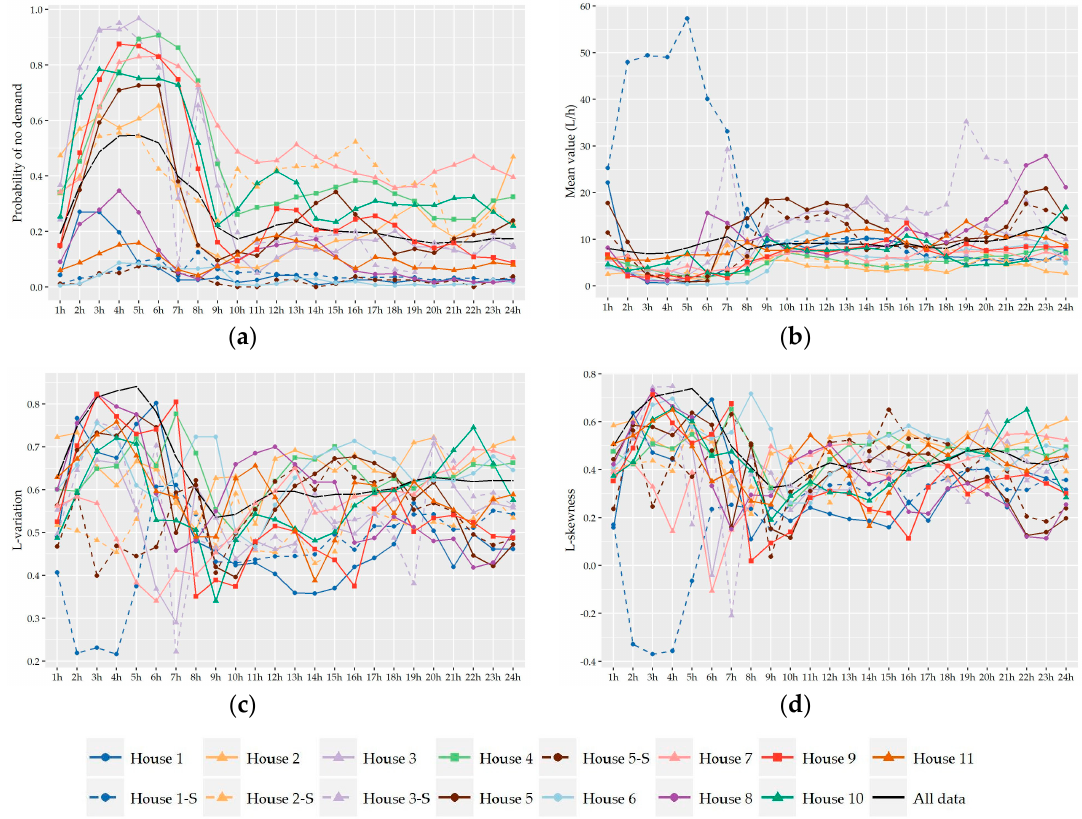
Figure 5. Hourly scale : Variation per hour of the probability of no demand ( a ), mean value ( b ), L-variation ( c ), and L-skewness ( d ) of the hourly nonzero demand records analyzed.